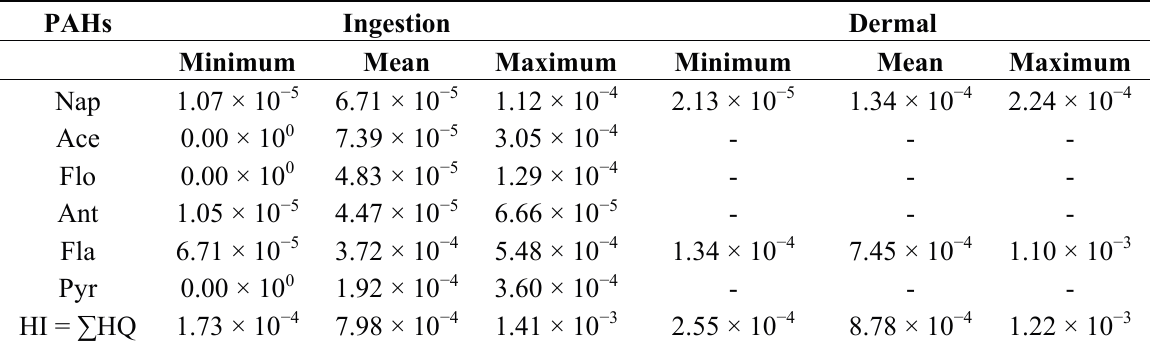
Table 4. Non-carcinogenic risk of